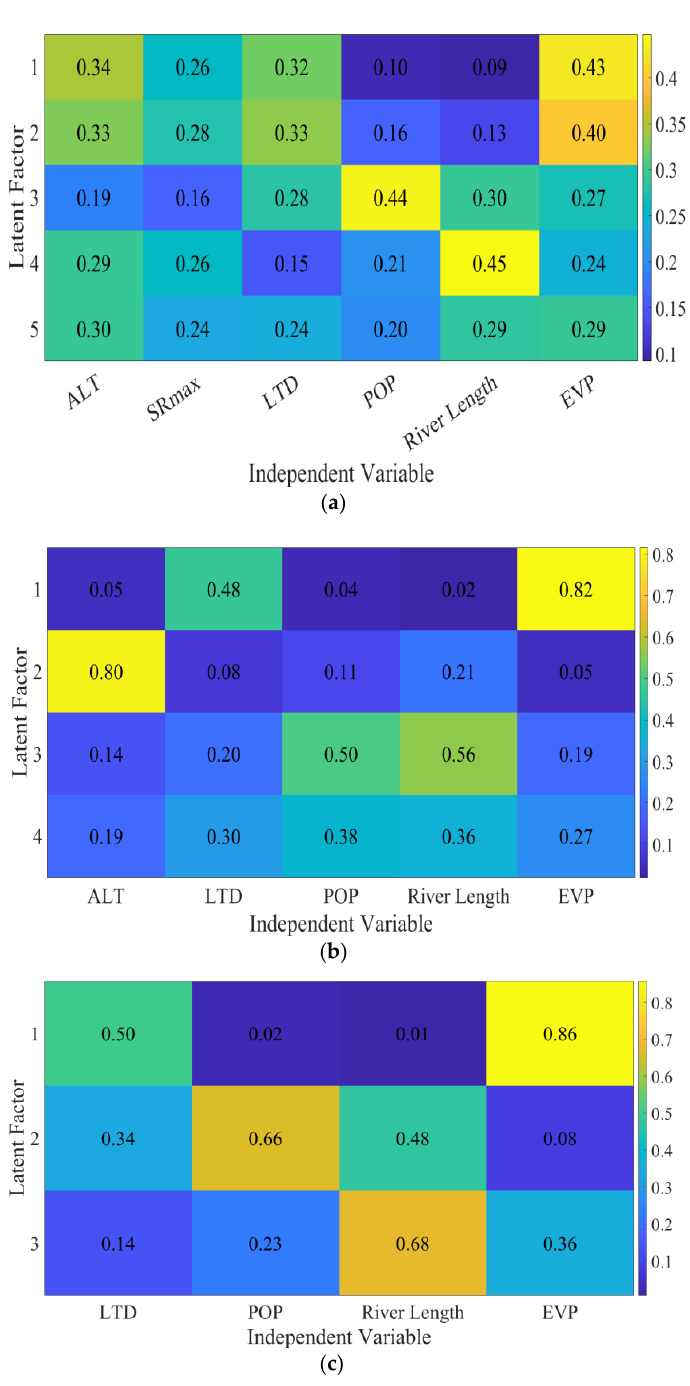
Table 2. Calculated drainage density (δ) and rock type in the sample areas in Hubei Province (see Table 1 for symbology).